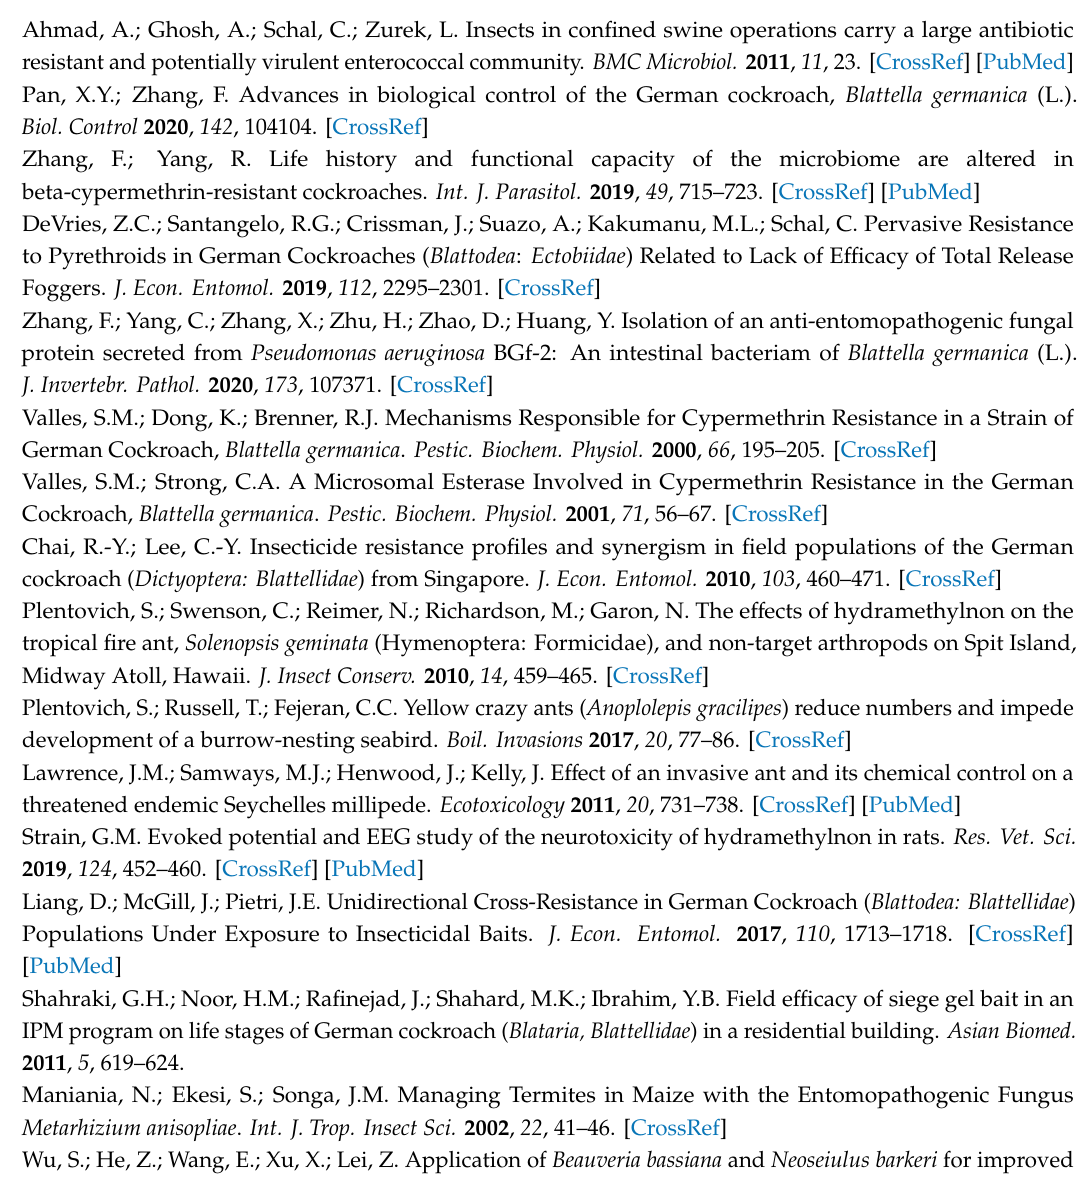
Figure S1: Rarefaction analysis of the di ff erent samples. Rarefaction curves of OTUs clustered at the 97% phylotype similarity level. Sobs represents the observed number of species. H, hydramethylnon sample; M, M. anisopliae sample; HM, hydramethylnon and M. anisopliae sample; C, control